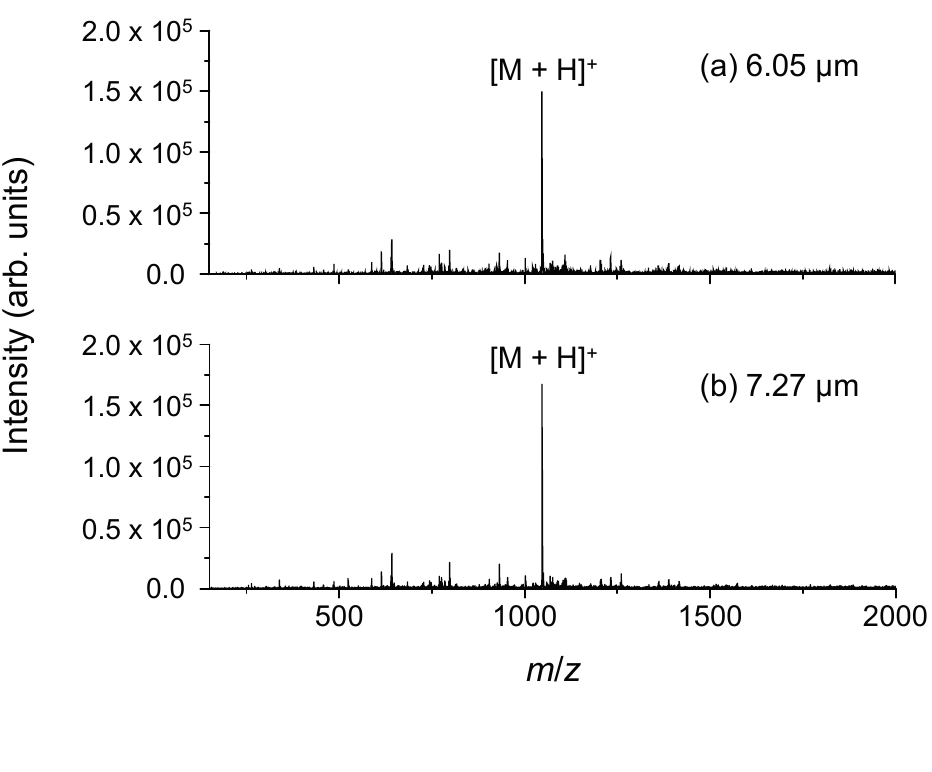
Figure 1. Typical mass spectra from angiotensin II dissolved in an 80% acetonitrile aqueous solution upon irradiation with a mid-infrared laser at wavelengths of ( a ) 6.05 µm and ( b ) 7.27 µm. The electric potential of the frit and the capillary temperature were set to 2.5 kV and 270 °C,